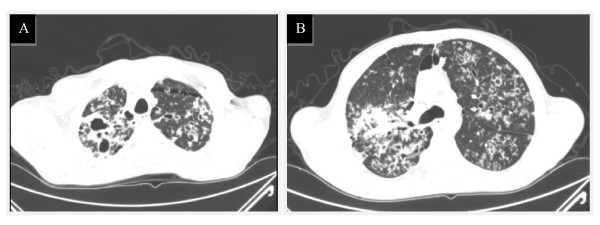
Chest CT angiography on admission. Multiple cavitary lesions in upper lobes and apical segments of lower lobes in communication with the bronquial tree (Figure 2A). Micronodules scattered in different pulmonary lobes with a "tree in bud" pattern. (bronquial disseminated tuberculosis). Hilar and paratracheal pericentimetric adenopathies were also identified (Figure 2B).